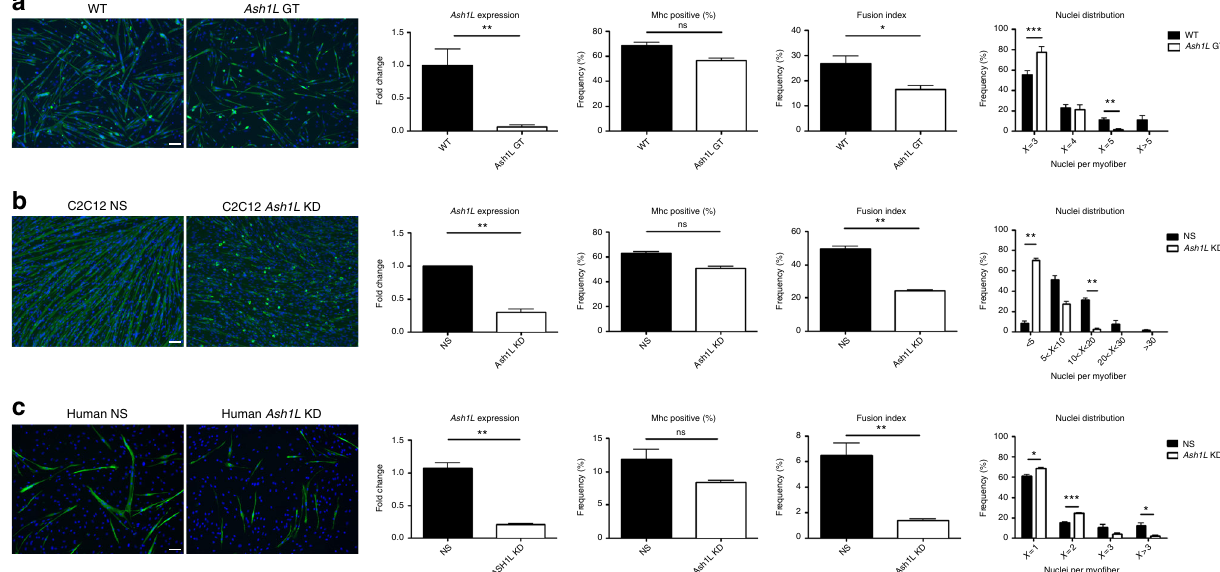
Fig. 3 Effects of Ash1L ablation on myoblast fusion. a Primary myoblasts isolated from Ash1L GT mice display a fusion defect. Immuno fl uorescence for myosin heavy chain (in green) and nuclear staining (Hoechst) in primary cultures from wild-type (WT) and Ash1L GT mice at E18.5 stage, after inducing differentiation for 48 h. Scale bar, 100 µ m. RT-qPCR analysis of Ash1L expression, validating Ash1L ablation in GT mice compared to wild-type mice. Percentage of Mhc-positive cells, calculated in comparison with the total number of nuclei. Fusion index, calculated as the number of nuclei present in myotubes (Mhc-positive and containing at least three nuclei) in comparison with the total number of nuclei. Nuclei distribution, calculated as the frequency of Mhc-positive cells containing the indicated number of nuclei. Unpaired two-tailed t test. Con fi dence intervals 95%. Results come from fi ve biological replicates. b Ash1L knockdown leads to a muscle fusion defect. Immuno fl uorescence for myosin heavy chain and nuclear staining in C2C12 cells transfected with non-targeting (NS) and Ash1L siRNAs ( Ash1L KD) and differentiated for 3 days. Scale bar, 100 µ m. Ash1L expression, percentage of Mhc-positive cells, fusion index, and nuclei distribution evaluated as described above. Unpaired two-tailed t test. Con fi dence intervals 95%. Results come from three